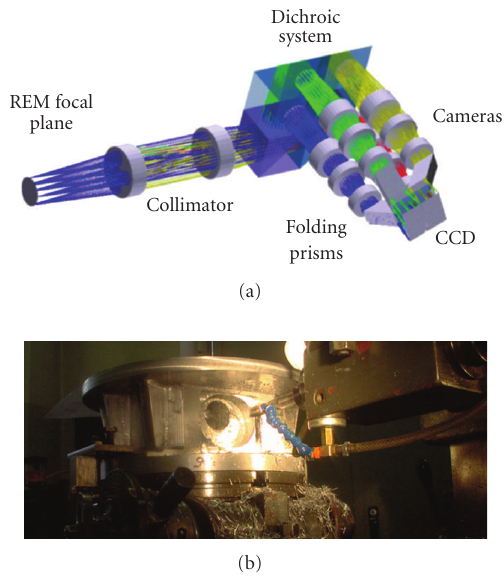
Figure 9: (a) ROSS2 visible camera optical layout: 4 separated images in four passbands will be recorded on a single 2K × 2K CCD. (b) The manufacturing of the mechanical interface for ROSS2 and